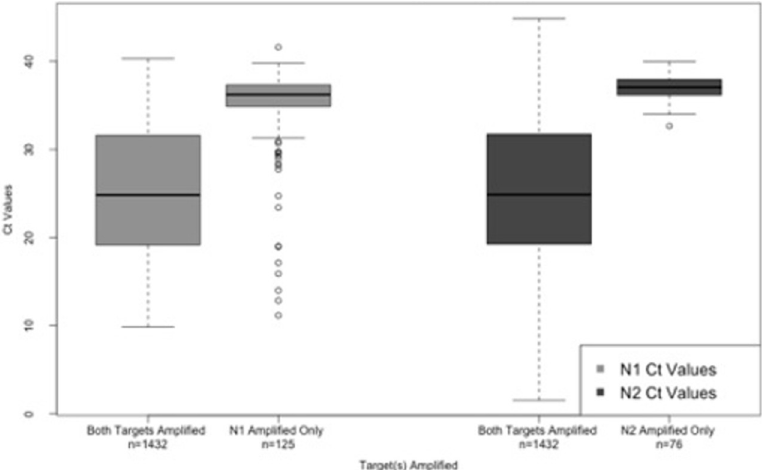
Fig 3. Comparison of N1 and N2 cycle threshold values for tests with both or only one target amplified.